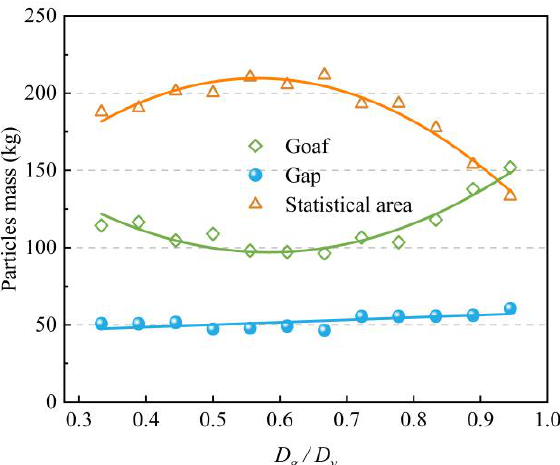
Figure 12. Barrel diameter versus distribution of particles in ejection mode ( D y = 900